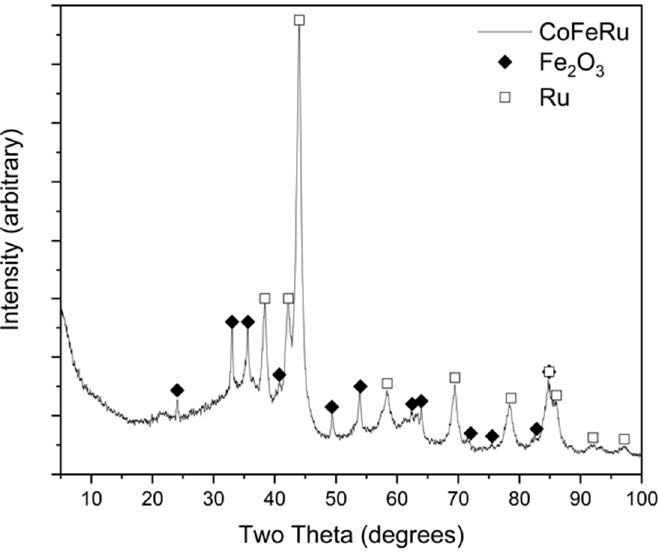
Figure 2. XRD pattern of unsupported CoFeRu electrocatalyst.